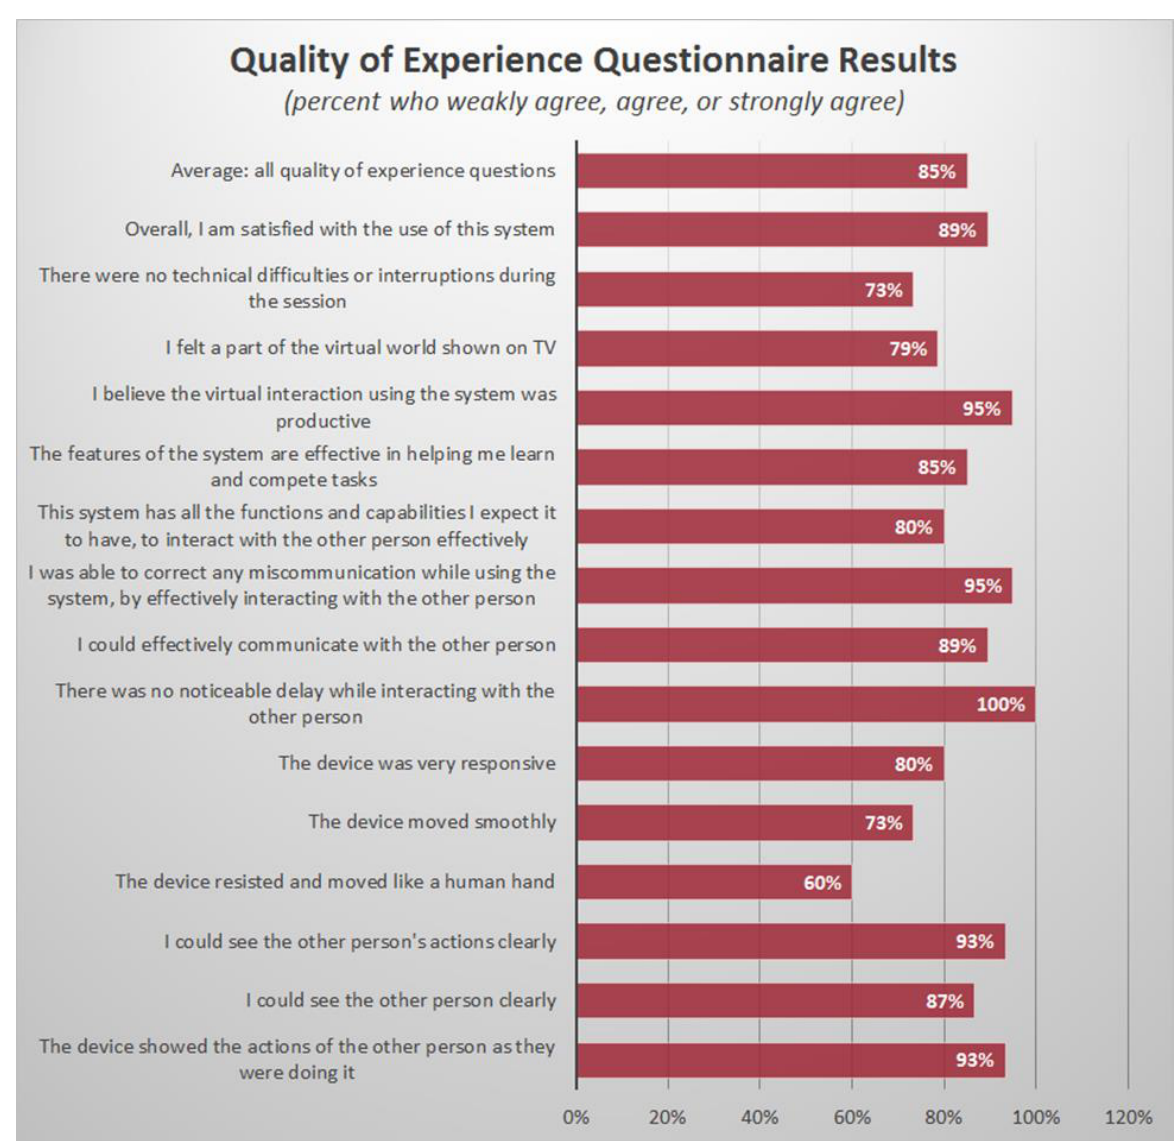
Figure 4. Results of “Quality of Experience” section of telehealth usability questionnaire reported as percent of respondents who rated > 4 on a 7-point Likert scale (corresponding to “weakly agree”, “agree”, or “strongly